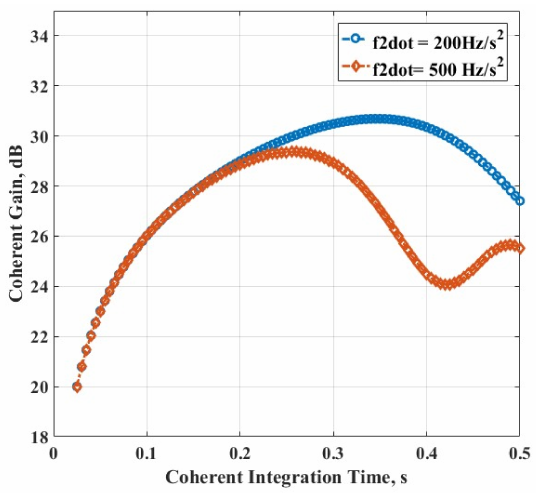
Figure 15. The coherent gain vs. coherent integration time for different second-order Doppler